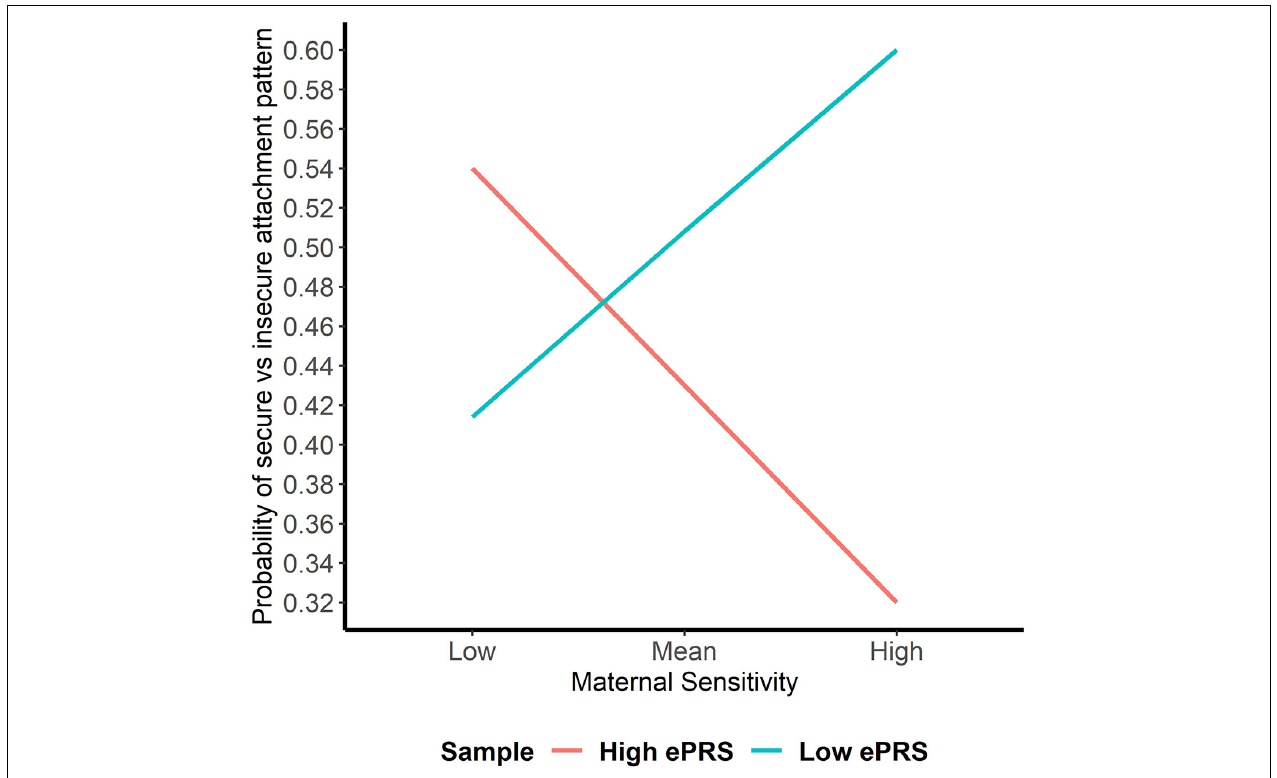
FIGURE 4 | Interaction between Striatal Gene Network and Maternal Sensitivity in Predicting Attachment. Shows that higher maternal sensitivity and a low CNR1 ePRS in the striatum predicts a higher probability of secure attachment. Higher maternal sensitivity and a high CNR1 ePRS in the striatum predicts a lower probability of secure